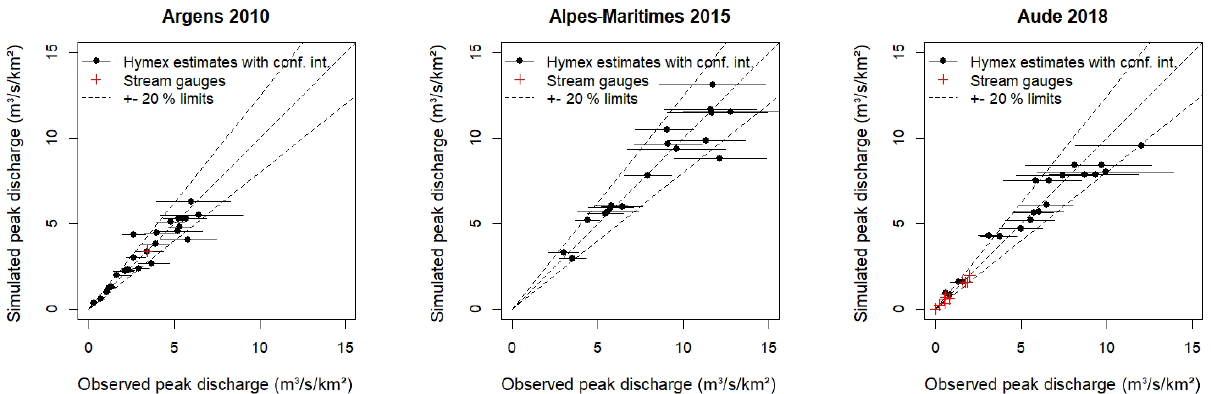
Figure 3. Observed vs. simulated peak discharges with the Cinecar rainfall–runoff model for the three simulated flood